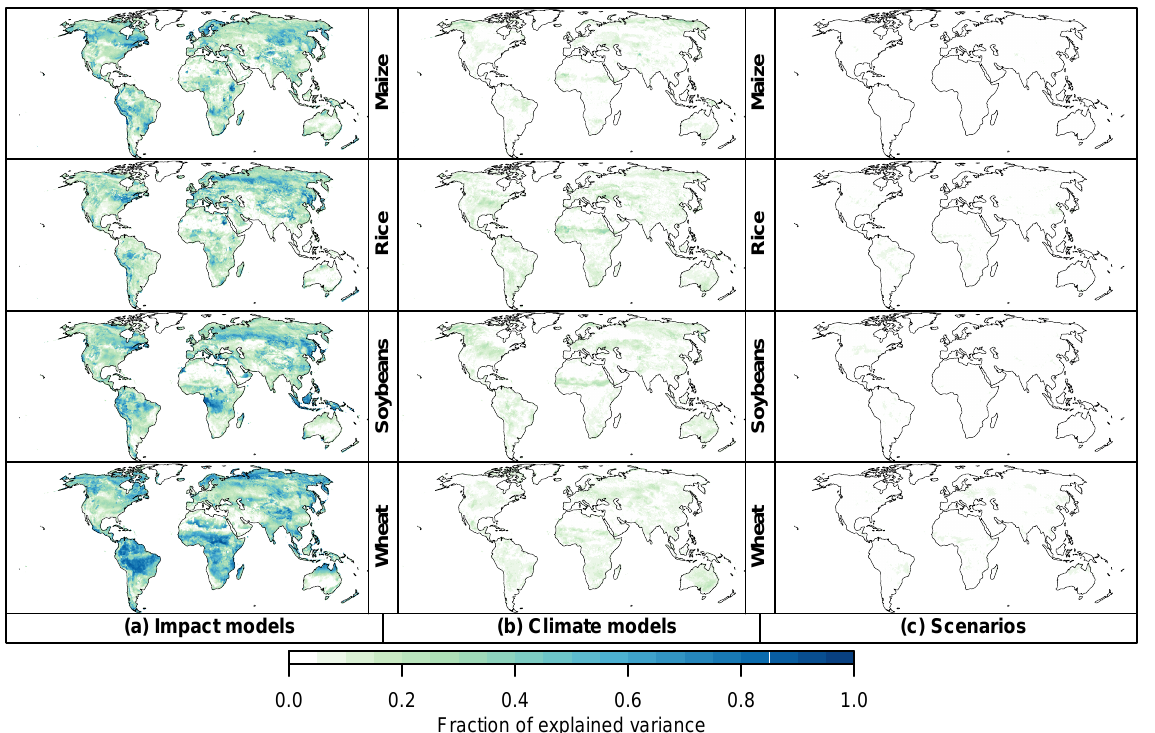
Figure 4. Fraction of total yield variance attributable to the impact models (GGCMs, a ), climate models (GCMs, b ), and scenarios (RCPs, c ) for each crop. Figure shown for rain-fed runs at (cid:49) GMT = 2.5 ± 0.25 ◦ C warming; an analogous figure for irrigated runs is provided in the